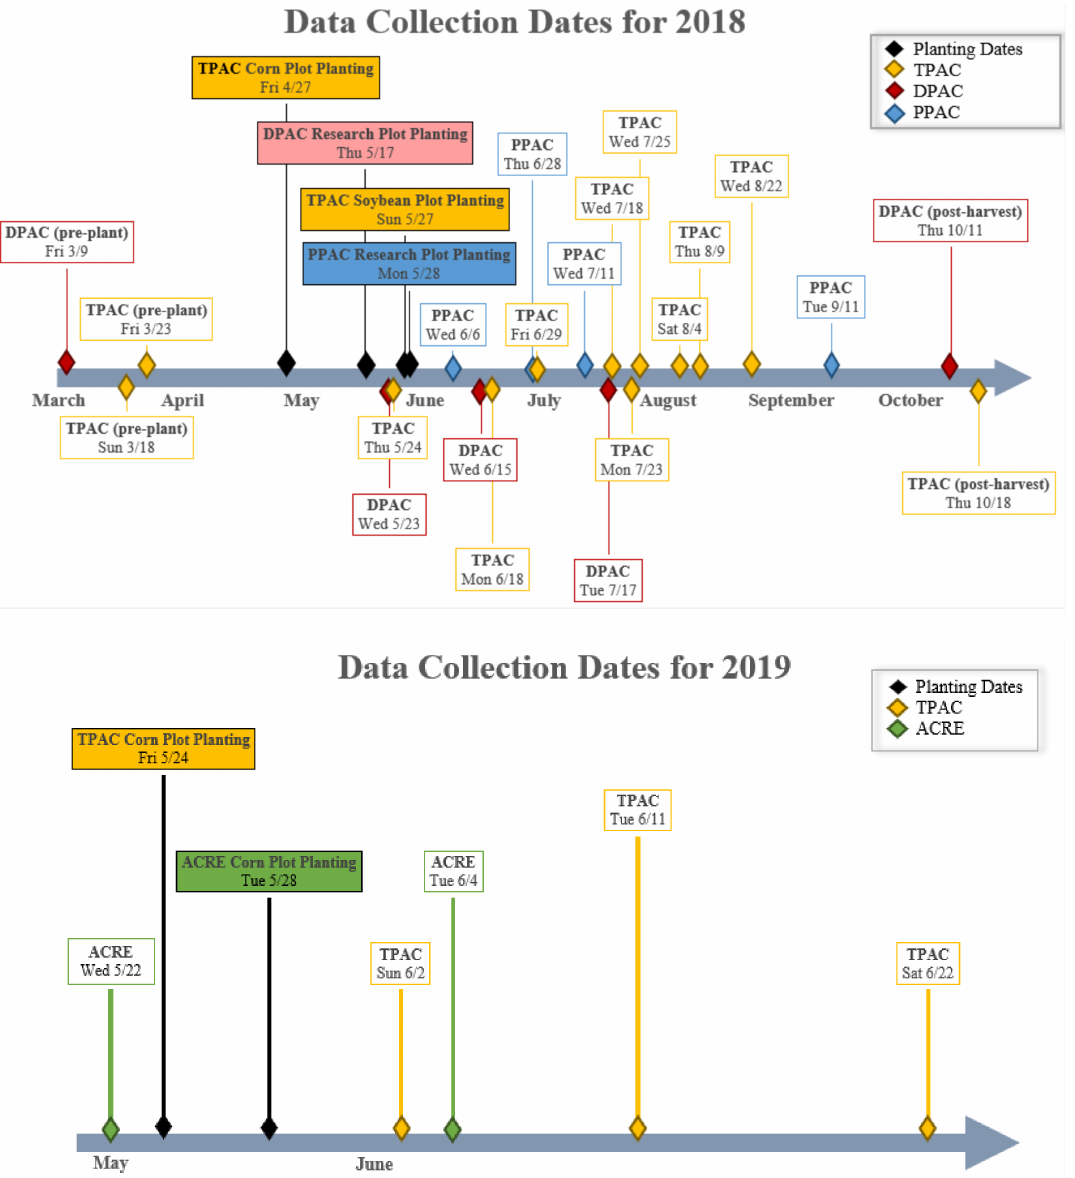
Figure 1. Data acquisition dates for 2018 and 2019. Each date also denotes where UAS flights were performed to collect data. Data collection was also done during the first month of the 2019 growing season at planting at these locations did not occur until late May. Planting at the TPAC and